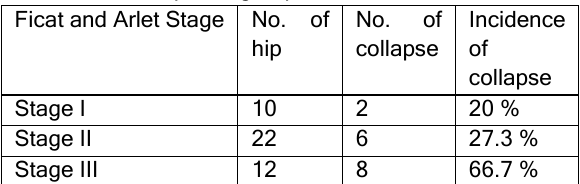
Table 3.Correlation between Ficat and Arlet stage, and incidence of collapse in group B